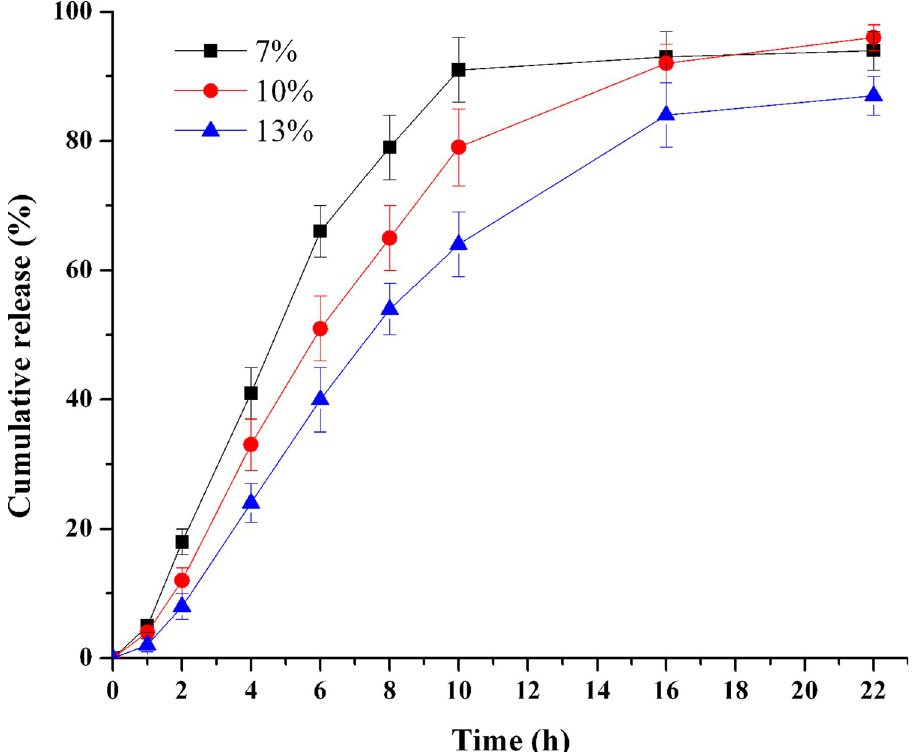
Fig 11. Effect of core tablet weight gain on TPM release (n =